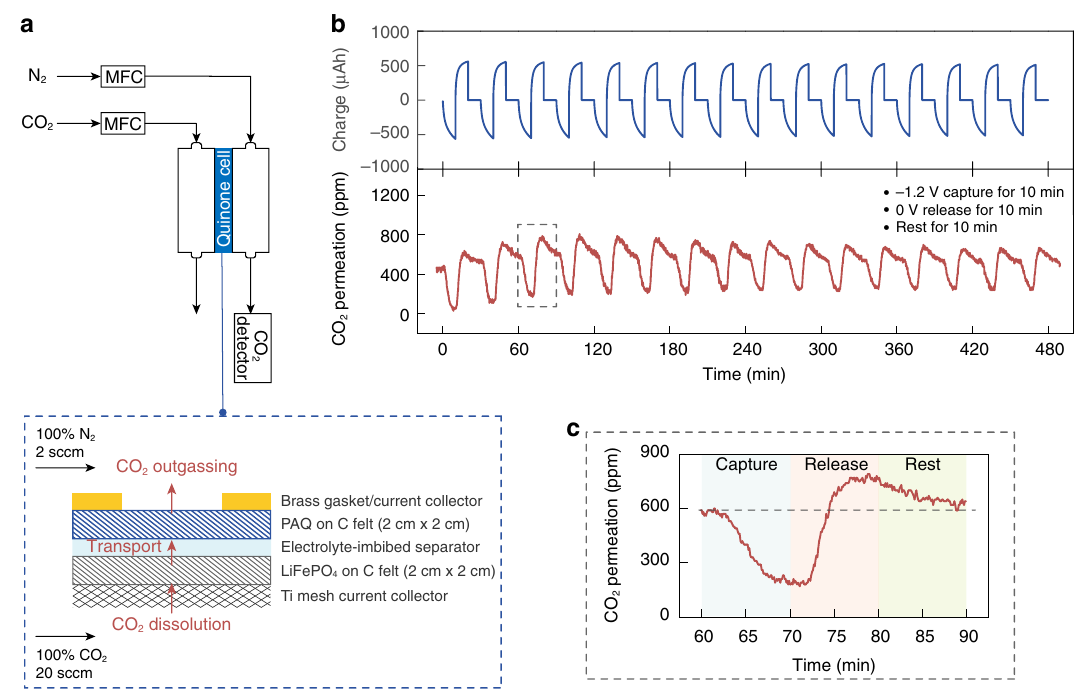
Fig. 6 CO 2 response during electrochemical quinone cycling. a Schematic illustrating the setup for the in situ measurement of CO 2 response during PAQ cycling. MFC stands for mass fl ow controller. The electrochemical cell consisted of PAQ-CNT (PAQ 1 mg cm − 2 ) and LiFePO 4 (8 mg cm − 2 ) electrodes cast on 50 μ m-thick carbon felt (2 cm × 2 cm in area), and the two electrodes were separated by a 20m LiTFSI-imbibed polypropylene separator. The electrochemical cell was mounted on a brass gasket with a 1 cm 2 circular opening to the gas fl ow chamber, which also served as the current collector for the PAQ-CNT electrode. A titanium mesh with little impedance to gas fl ow was used as the current collector for LiFePO 4 . Pure CO 2 fl owed on one side of the electrochemical cell and pure N 2 fl owed on the other side to carry permeated CO 2 to the in-line gas detector. The testing employed a “ zero-gap ” design where the electrochemical components were all in close contact, such that CO 2 cross-over can only occur via dissolution-diffusion through the electrolyte. b CO 2 permeation in response to the electrochemical cycling of the PAQ-LiFePO 4 cell, and the corresponding oxidation/reduction charge pro fi les. c Detailed CO 2 permeation behavior during one capture-release cycle marked with a dashed line in ( b ). The cycling was conducted following a constant voltage capture-release protocol (capture at − 1.2 V for 10 min, release at 0 V for 10 min, rest 10 min). Source data are provided as a Source Data fi